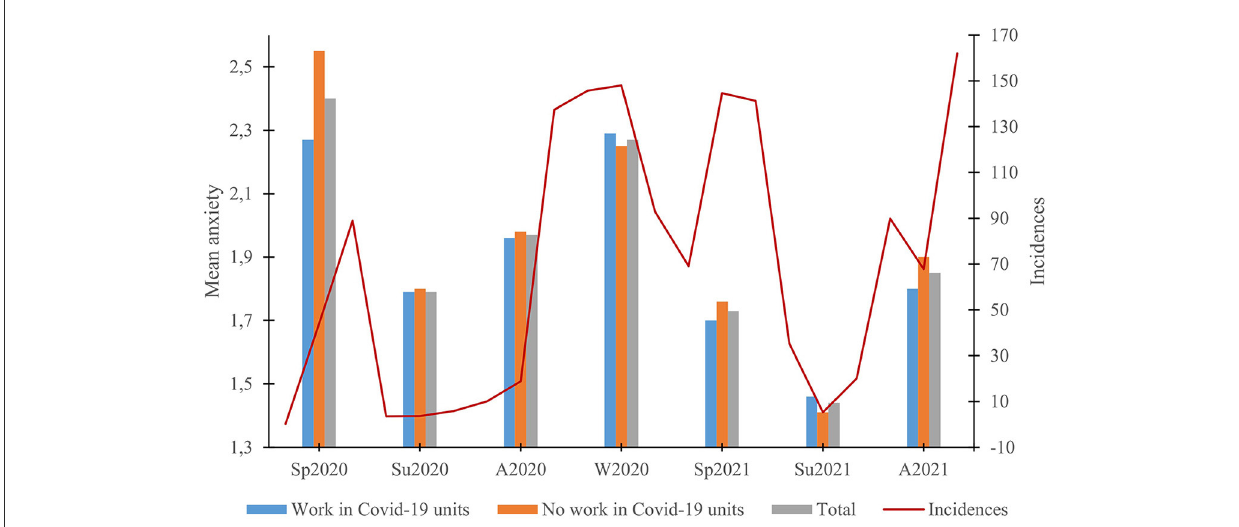
FIGURE1 Subjective anxiety over time. Presentation of mean anxiety scores at the different measurement time points for the total sample and the “work in COVID-19 units” and “no work in COVID-19 units” subsamples in relation to the nationwide COVID-19 7-day incidence rate over time at the beginning of each month (20/03: 0,2; 20/04: 44; 20/05: 89; 20/06: 3,5; 20/07: 3,6; 20/08: 5,8; 20/09: 10,1; 20/10: 18,8; 20/11: 137,4; 20/12: 145,7; 21/01: 148; 21/02: 92,9; 21/03: 69,1; 21/04: 144,6; 21/05: 141,2; 21/06: 35,3; 21/07: 5,3; 21/08: 20; 21/09: 89,9; 21/10: 67,8; 21/11: 162) Source: Robert Koch Institut (RKI): COVID-19 trends in Germany in an overview: https://www.rki.de/DE/Content/InfAZ/N/Neuartiges_Coronavirus/ Situationsberichte/COVID-19-Trends/COVID-19-Trends.html?__blob$=$publicationFile#/home; Access: 02.05.2022.